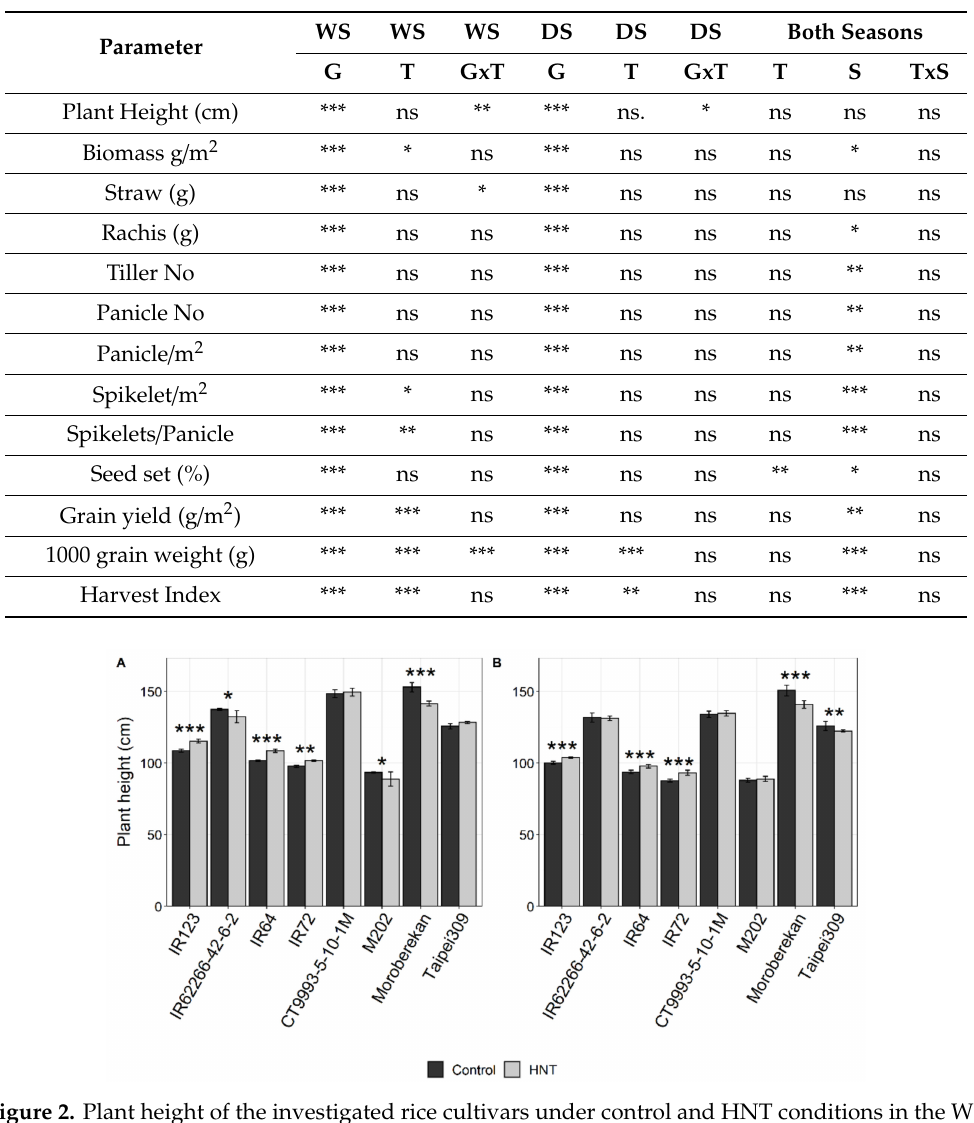
Figure 2. Plant height of the investigated rice cultivars under control and HNT conditions in the WS ( A ) and DS ( B ). Bars for the WS represent means ± SEM of 24 plants per condition, and bars for the DS, those of 60 plants per condition. Cultivars are sorted alphabetically within the respective O. sativa subspecies indica (1–4) and japonica (5–8). Significance levels are indicated by asterisks: 0.001 < ***; 0.001 > ** < 0.01; 0.01 > * <